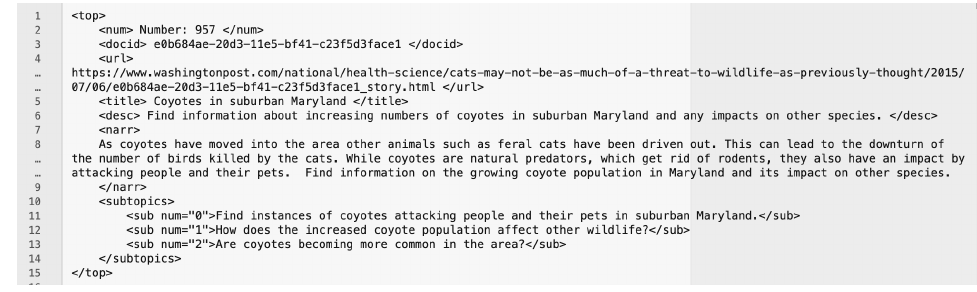
Figure 14. Sample article chosen as a topic for the calculation of